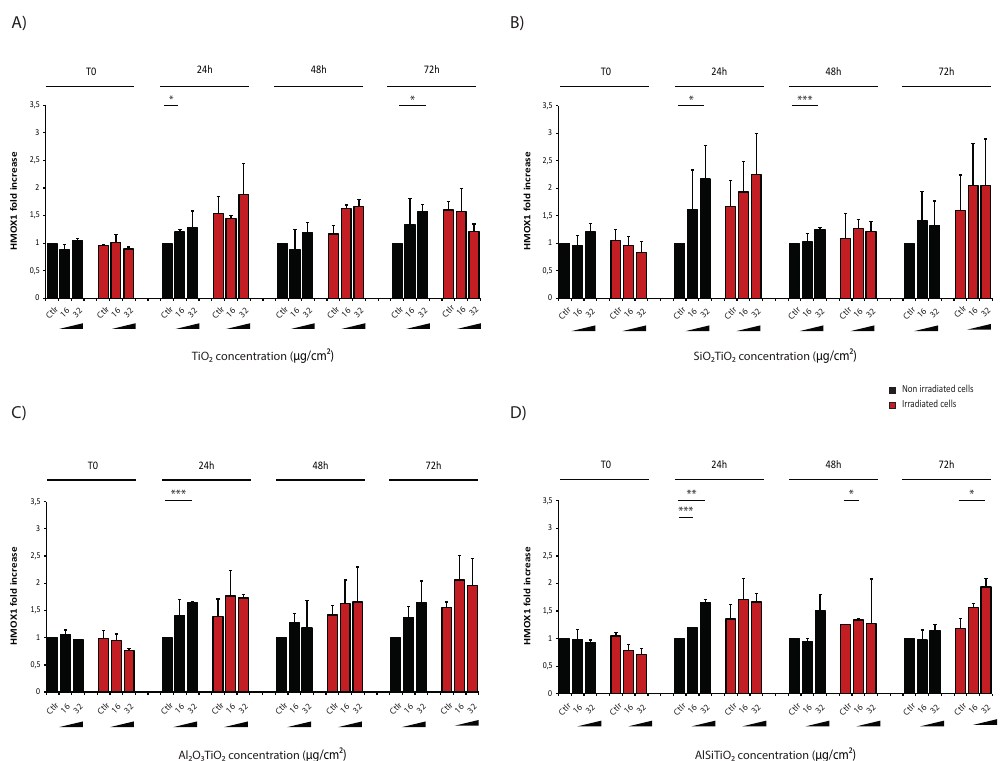
Figure 5. HMOX1 detection by quantitative real time polymerase chain reaction. Human bronchial epithelial 16HBE cells were maintained in control conditions (Ctlr) or treated with 16 or 32 μg/cm2 of ( A ) titanium dioxide (TiO 2 ), ( B ) silica coated titanium dioxide (SiO 2 TiO 2 ), ( C ) aluminum coated titanium dioxide (Al 2 O 3 TiO 2 ) or ( D ) double silica and aluminum coated titanium dioxide (AlSiTiO 2 ), and 4 Gy irradiated or not. ARN extractions were performed immediately (T0), 24 h, 48 h or 72 h after treatment and quantitative RT-PCR were realized to detect HMOX1 gene expression. Representative dot plots normalized by the value of the untreated non-irradiated control for each time point are shown (means ± S.D., n = 2). * p < 0.05, ** p < 0.01, *** p < 0.001 (Student’s t -test), as compared with the control group